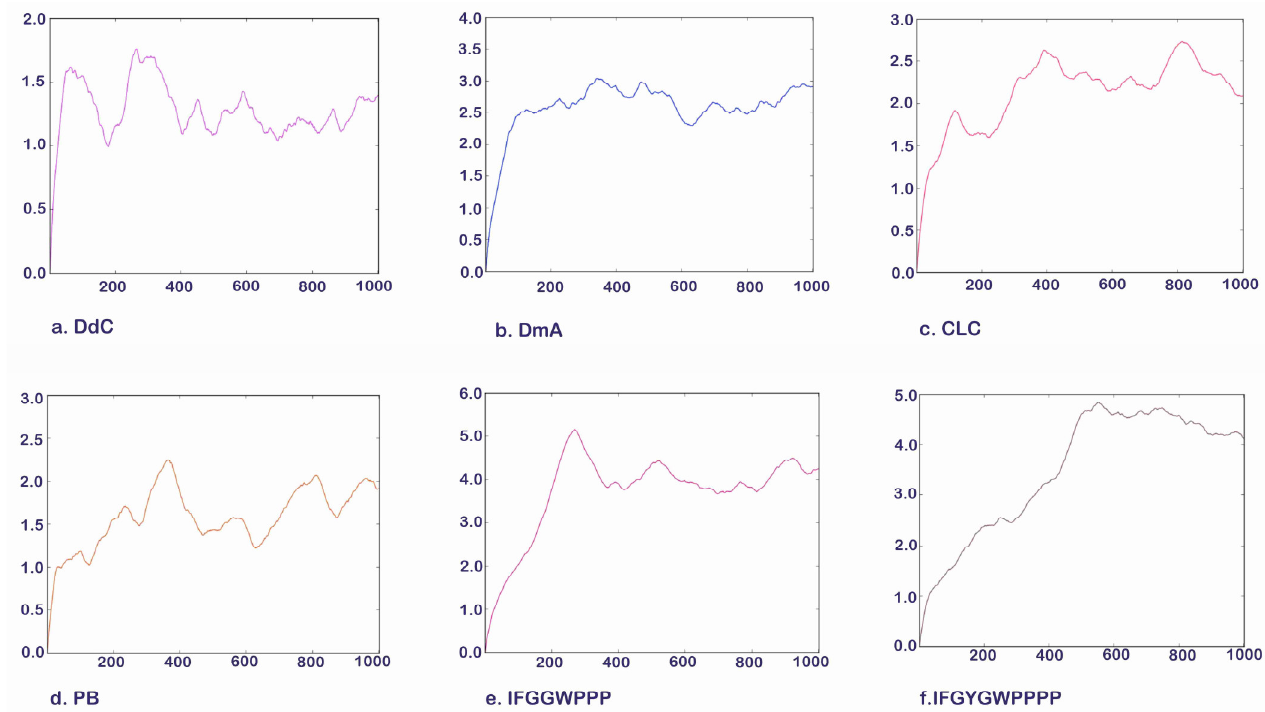
Figure 14. Molecular dynamics simulation. Vertical axis: RMSD (Å). Horizontal axis: number of frames. Table 4. Average RMSD and energy (KJ) obtained from molecular dynamics simulations.